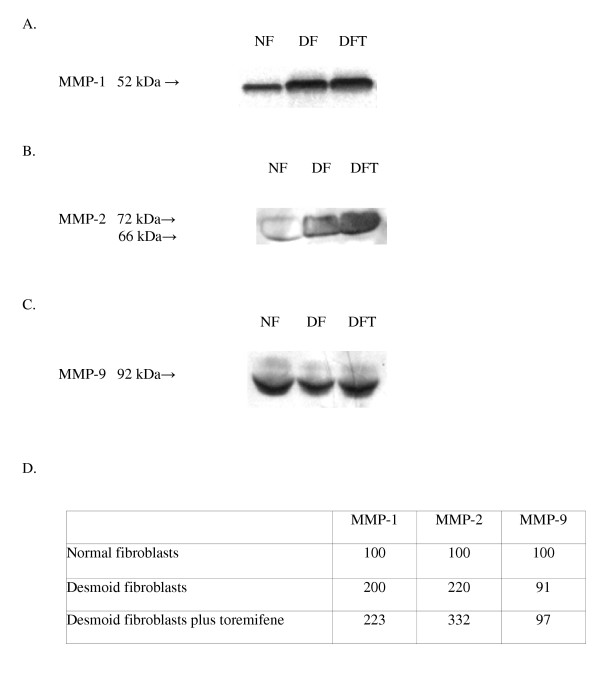
Western blot analysis of MMP-1, MMP-2, MMP-9 secreted into the medium. Panel A: MMP-1; panel B: MMP-2; panel C: MMP-9. The samples are as follows: NF, normal fibroblasts; DF, desmoid fibroblasts; DFT, desmoid fibroblasts plus toremifene. Similar results were obtained in four separate experiments. Panel D. The absolute counts, obtained by densitometric analysis, were converted to percentages assuming the level of normal fibroblasts as 100%. ND = not determined.